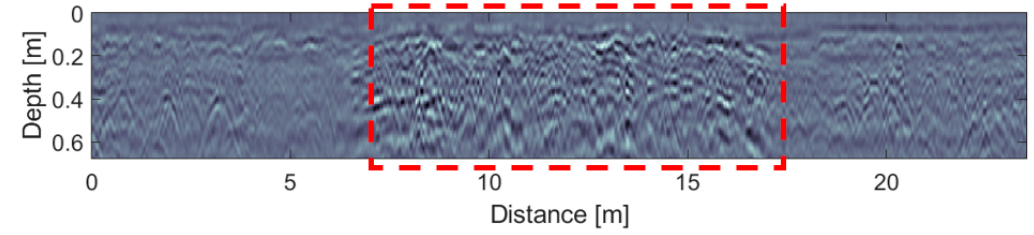
Figure 8. A B-scan showing the presence of a buried structure (highlighted by the red dashed square).